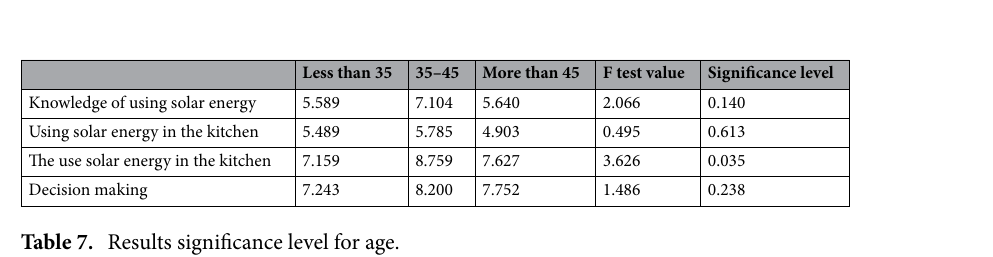
Table 7. Results significance level for age.